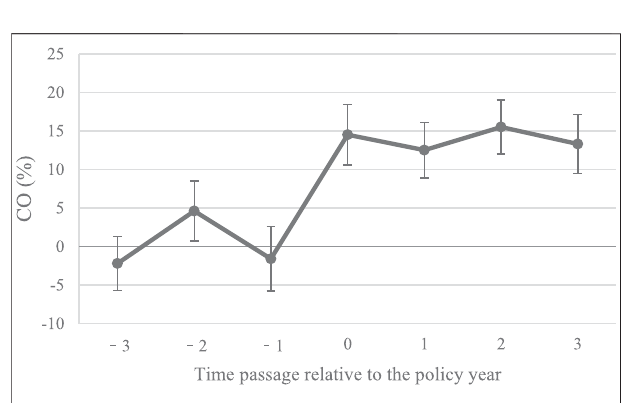
FIGURE 10 | The parallel trend test for the CO.